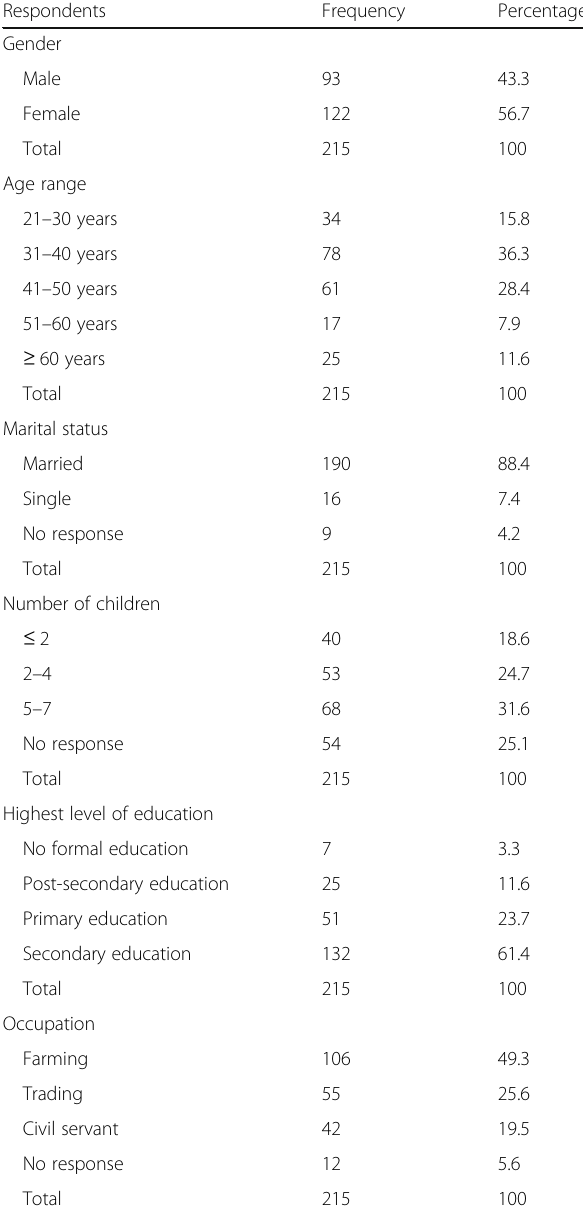
Table 1 Respondent demographic